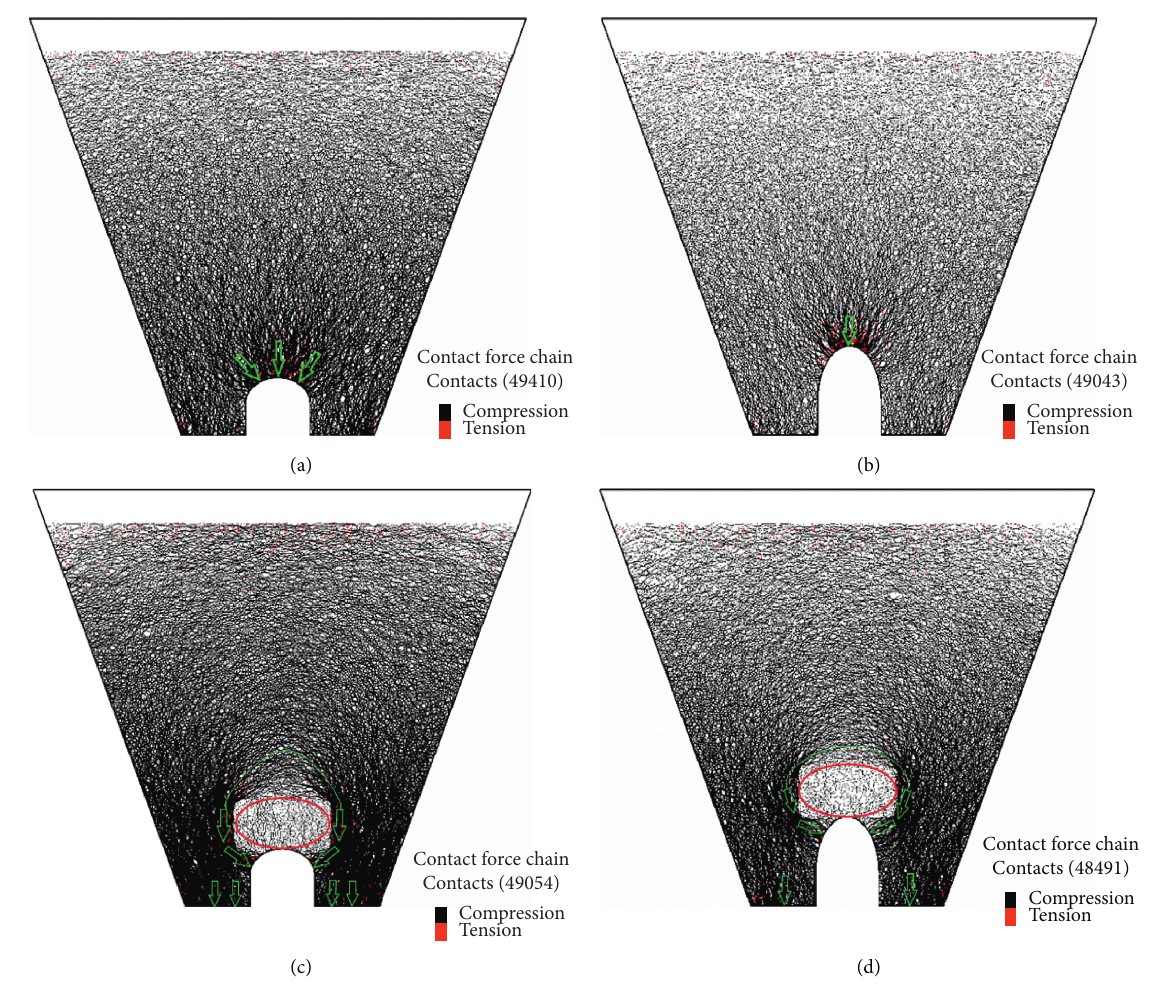
Figure 14: Contact force chain for cases (a) S1, H/S � 0.4; (b) S1, H/S � 0.9; (c) S2, H/S � 0.4; (d) S2, H/S � 0.9.